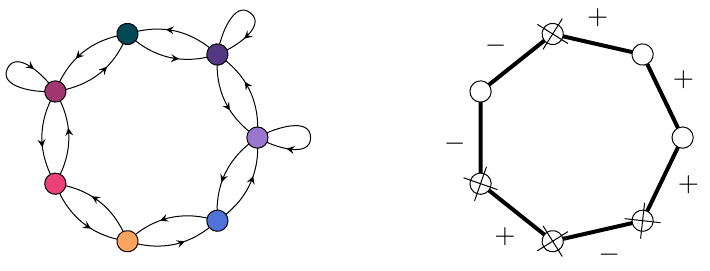
Figure 1 . An example of a quiver and a Dynkin diagram associated with signature Σ = { +1 , +1 , +1 , − 1 , − 1 , +1 , − 1 }